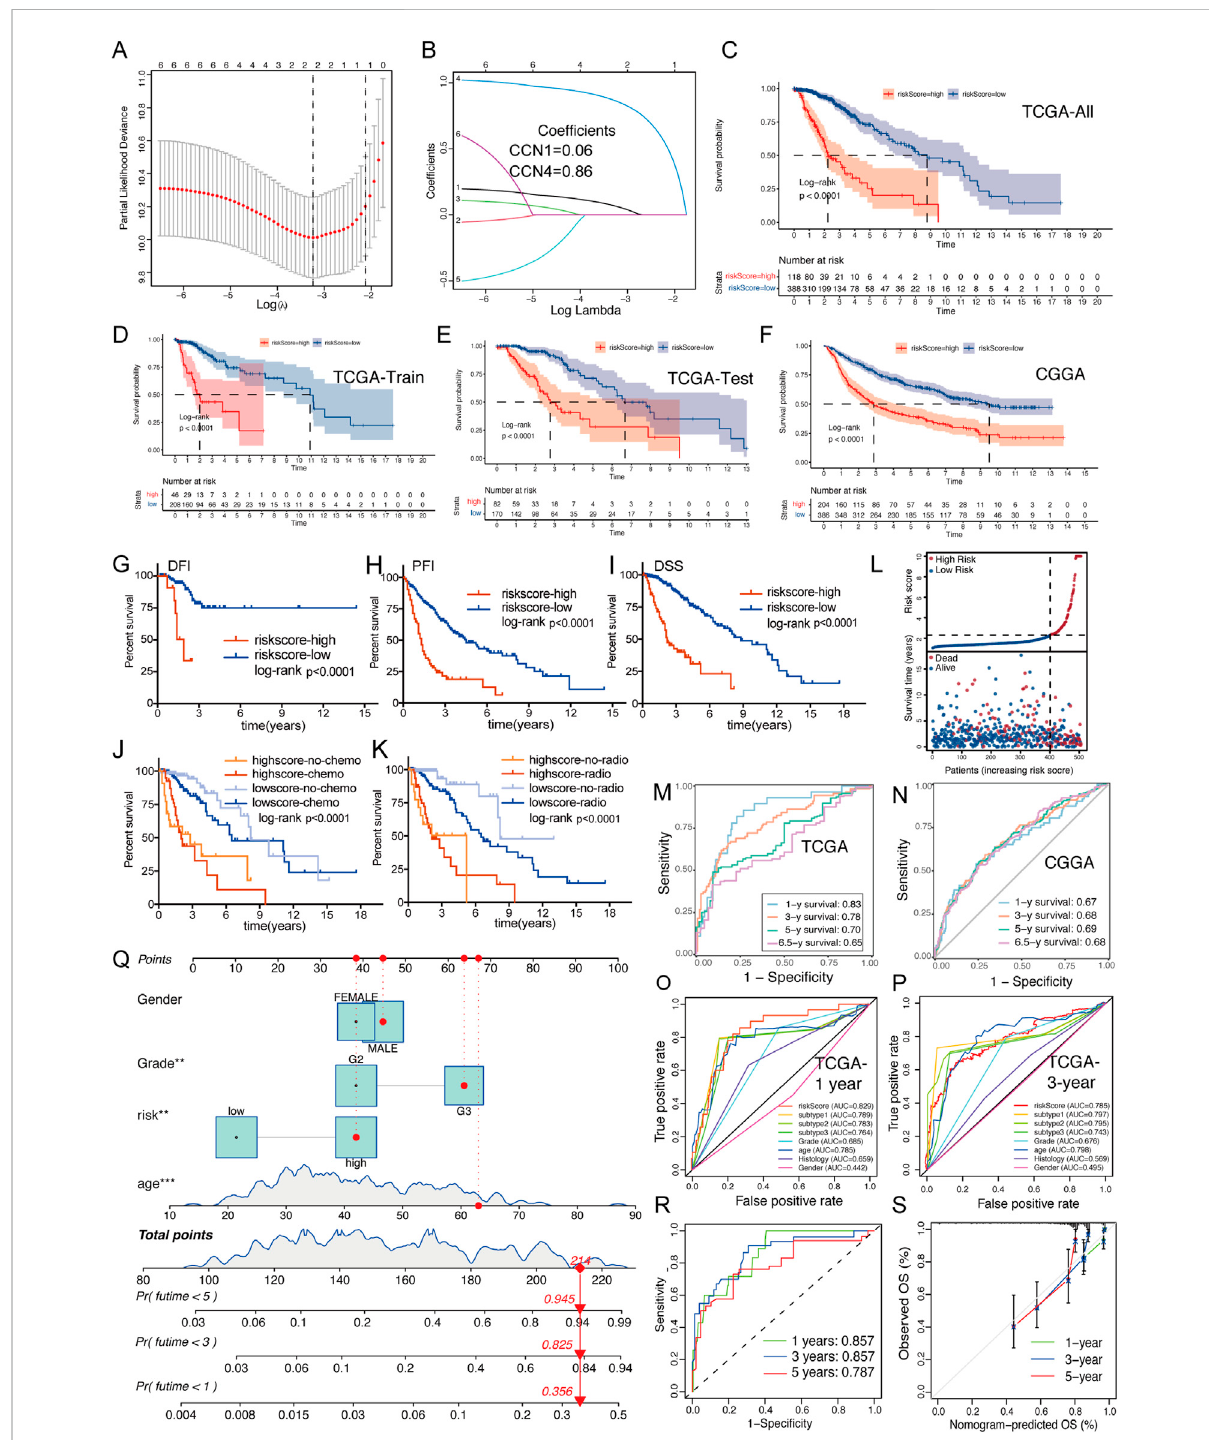
FIGURE 3 Creation and validation of CCNScore. (A,B) LASSO regression was performed, calculating the minimum criteria. (C – F) Overall survival analysis wasperformedofallTCGA-LGGset (C) andtworobustclusters-TCGAtrainset (D) andTCGAtestset (E) ,aswellasCGGA-LGGcohort (F) tovalidate CCNScore. (G – I) Survival analysis was performed using CCNscore, with DFI (G) , PFI (H) and DSS (I) as endpoint in the TCGA-LGG cohort. (J,K) Strati fi ed survival analysis was performed according to radiotherapy (J) , chemotherapy (K) and CCNscore. (L) Risk curve of CCNscore was plotted using the TCGA-LGG cohort. (M,N) ROC curves indicated the risk prediction ability of CCNScore at 1, 3, 5, and 6.5 years in the TCGA- LGGcohort(M)andCGGA-LGGcohort(N). (O,P) ROCcurves showedtheaccuracyofCCNscorevs.otherclinicaltraitsto predictprognosisat1and